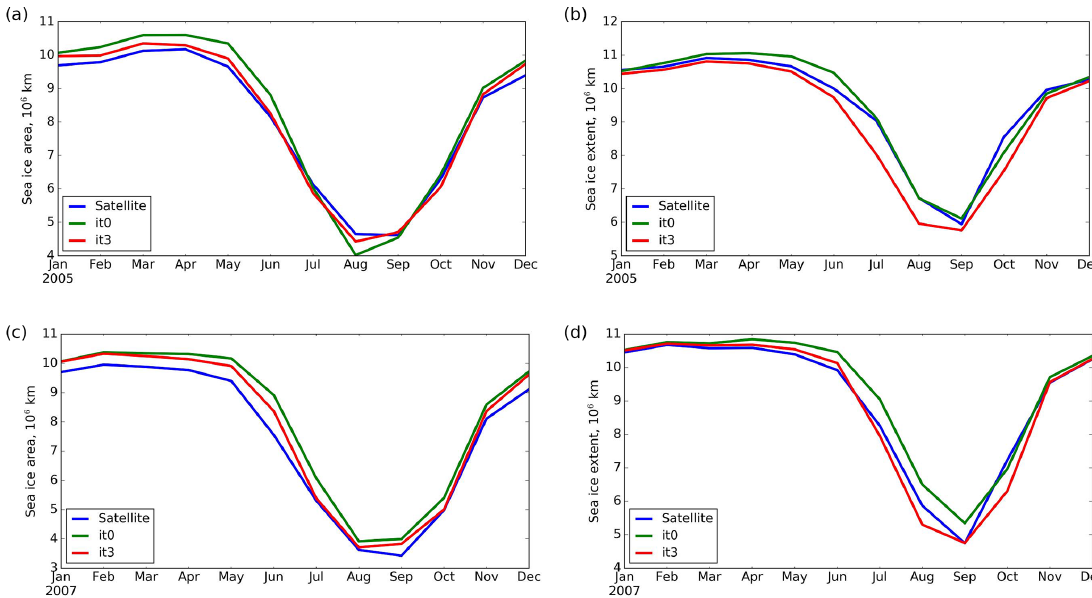
Figure 5. Monthly mean sea ice area (a, c) and extent (b, d) for the years 2005 (a, b) and 2007 (c, d) . Assimilated satellite data is shown in blue, and model solution without corrections is shown in green and the result from the last iteration is shown in